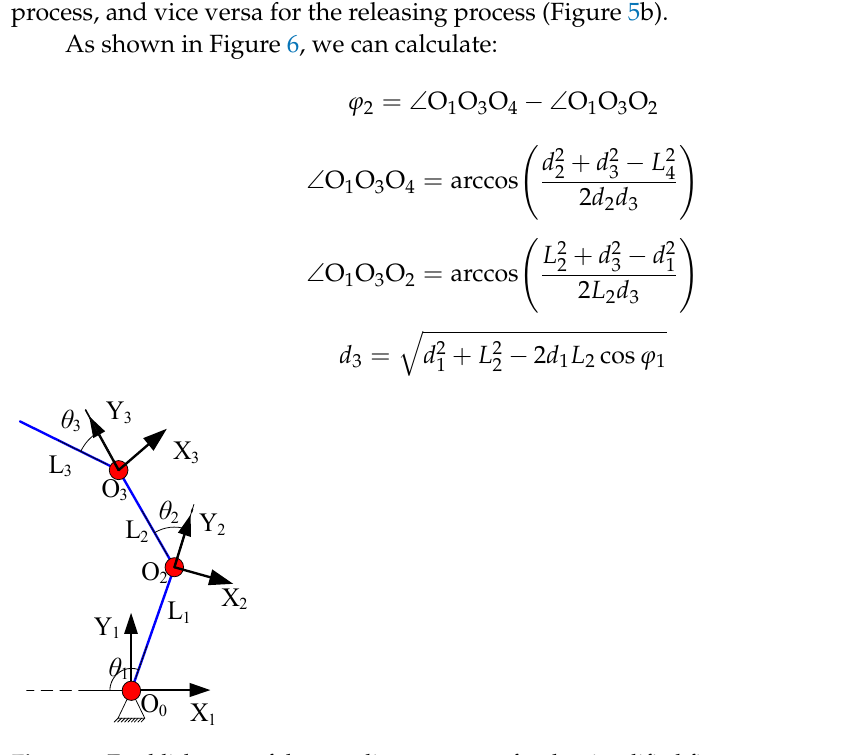
around the points O 3 and O 2 , respectively. At this time, the fingers were in the grasping